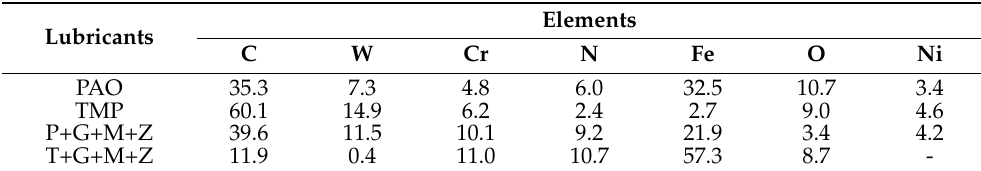
Table 6. Elemental atomic percentage found on a-C:H:W-coated tappets after cylinder head testing under various conditions in combination with a-C:H:W-coated camlobes in the presence of PAO- based and TMP-based